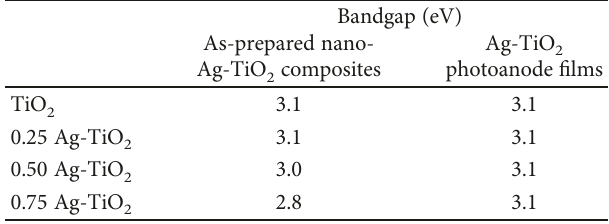
) of the as-prepared nano-Ag-TiO g photoanode fi lms, calculated 2